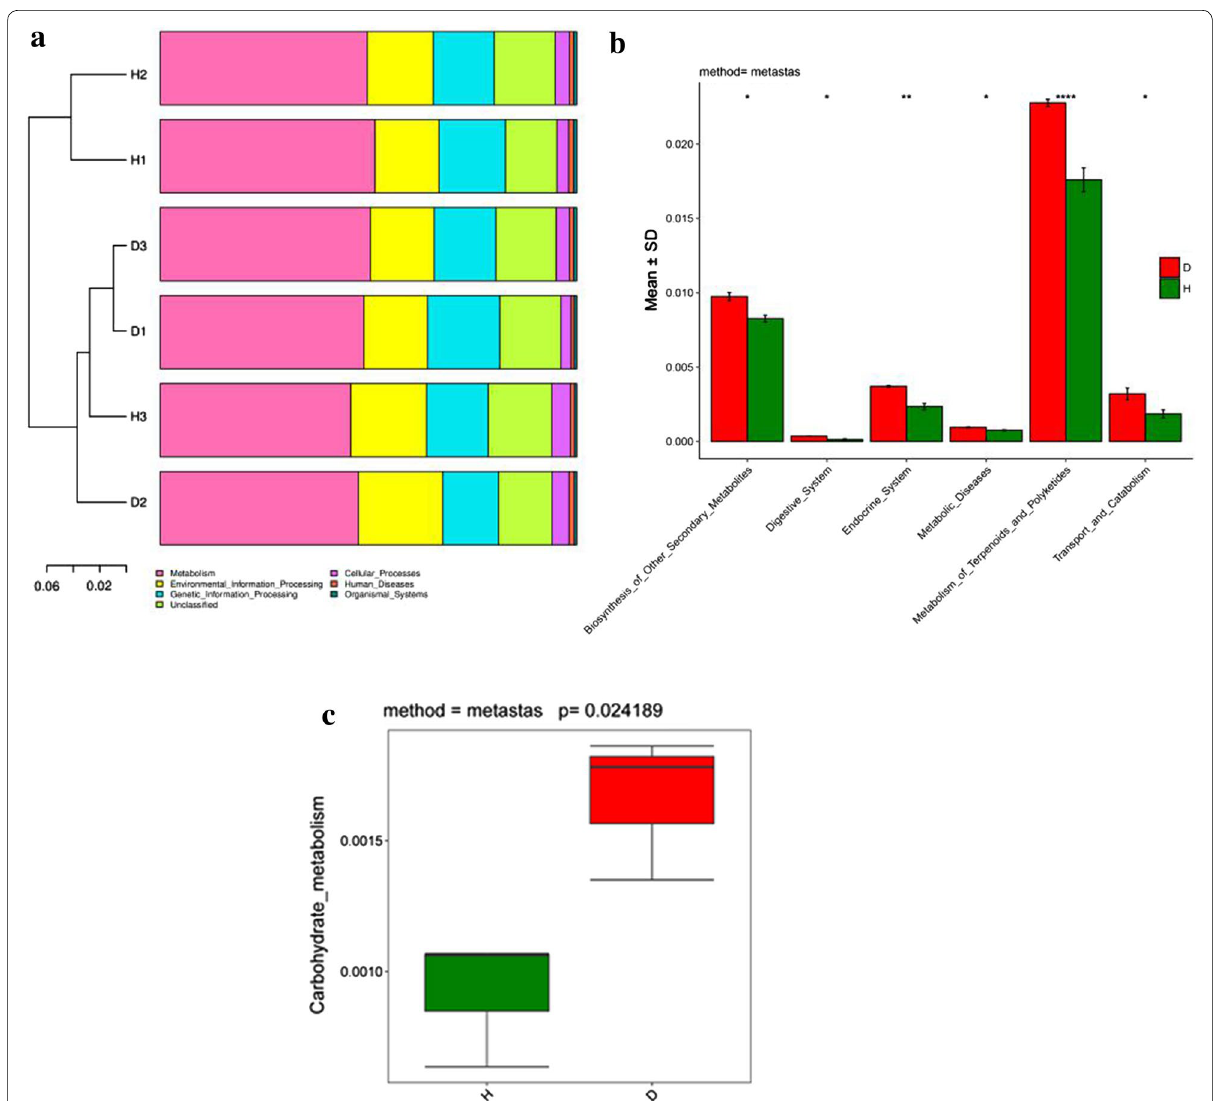
Fig. 7 a The functional composition of the intestinal microbiota in Yunlong Grouper and cluster analysis. b In the level-2 term, significant changes are evident in intestinal microbiota KEGG pathways between healthy and diseased Yunlong Grouper, determined by the software Metastats. c Box-plots showed the significant predictive functions (carbohydrate metabolism) of the intestinal microbiota in both the healthy and